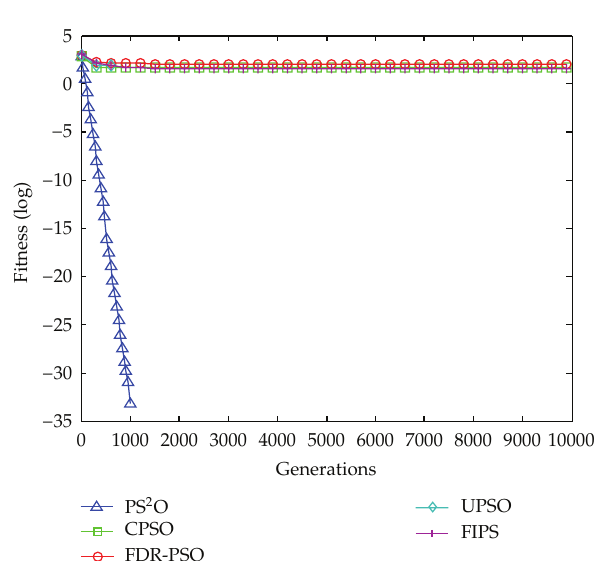
Figure 9: The median convergence results Composition function 1.